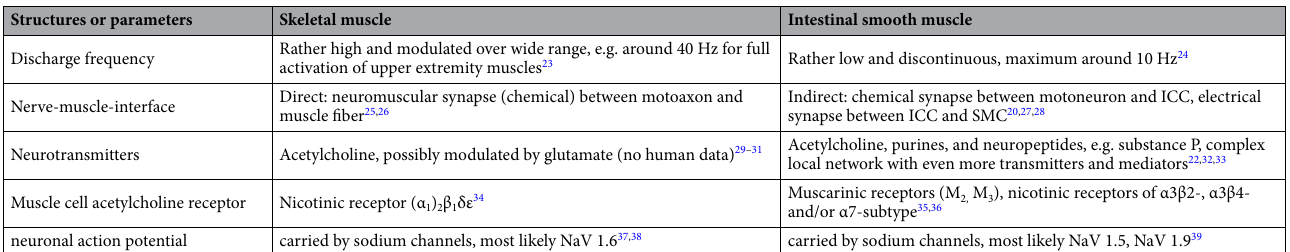
Table 1. Selected differences between skeletal muscle cells, smooth muscle cells and their respective motoneurons.